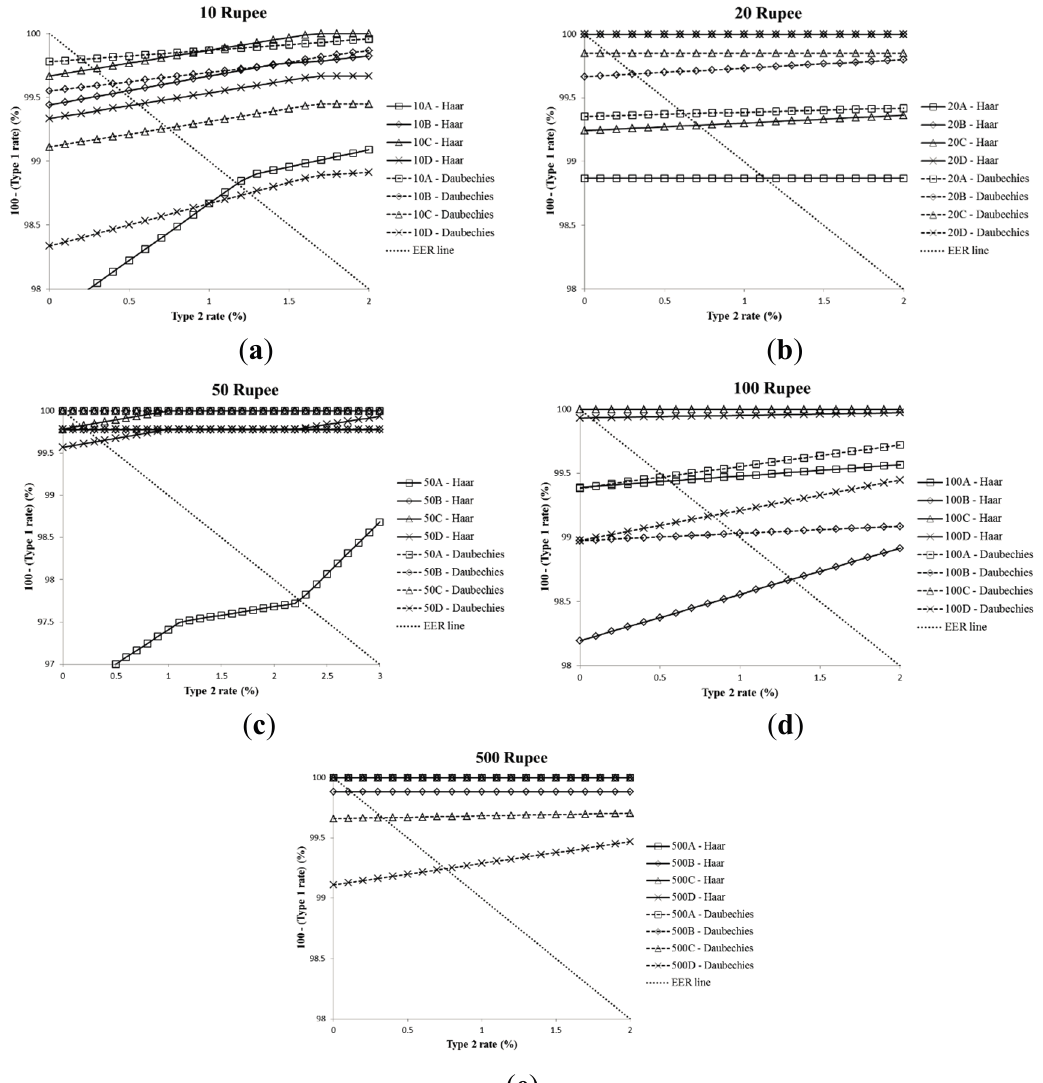
Figure 6. Average ROC curves of SVM testing process of the cases in Tables 4 and